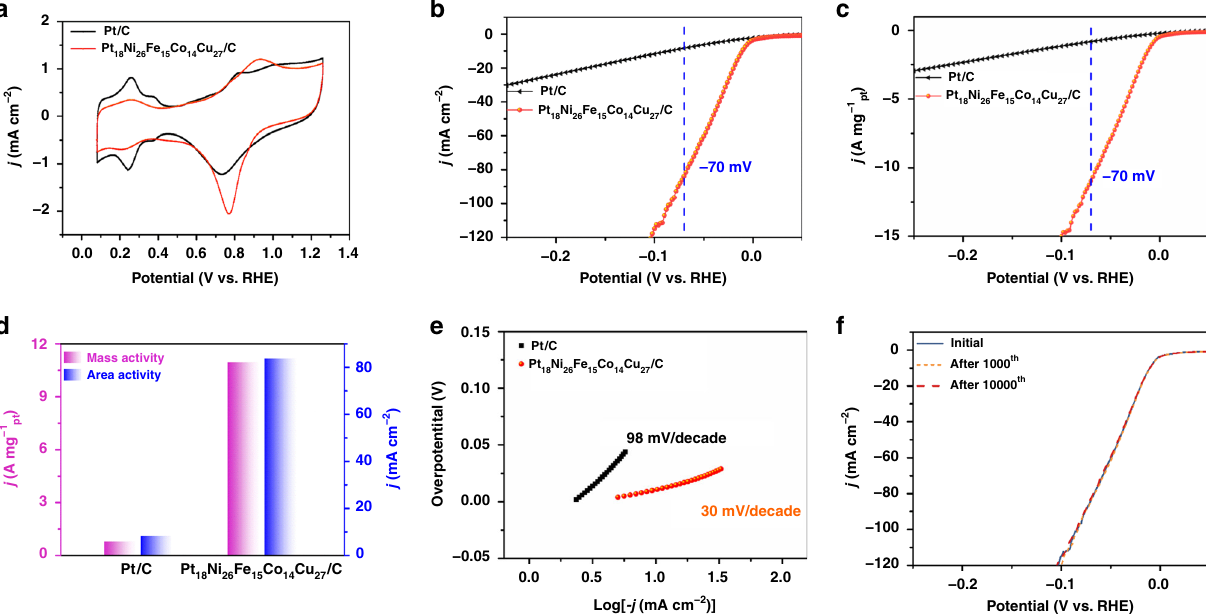
Fig. 2 Electrocatalytic performance of the Pt 18 Ni 26 Fe 15 Co 14 Cu 27 /C and Pt/C for HER in 1 M KOH electrolyte. a CV curves. b HER polarization curves (geometrical area). c Pt mass loading normalized (mass activity) LSV curves. d Comparison of area activity and mass activity values for HER at − 70 mV vs. RHE. e Tafel slope. f HER polarization curves (geometrical area) for Pt 18 Ni 26 Fe 15 Co 14 Cu 27 /C with different CV